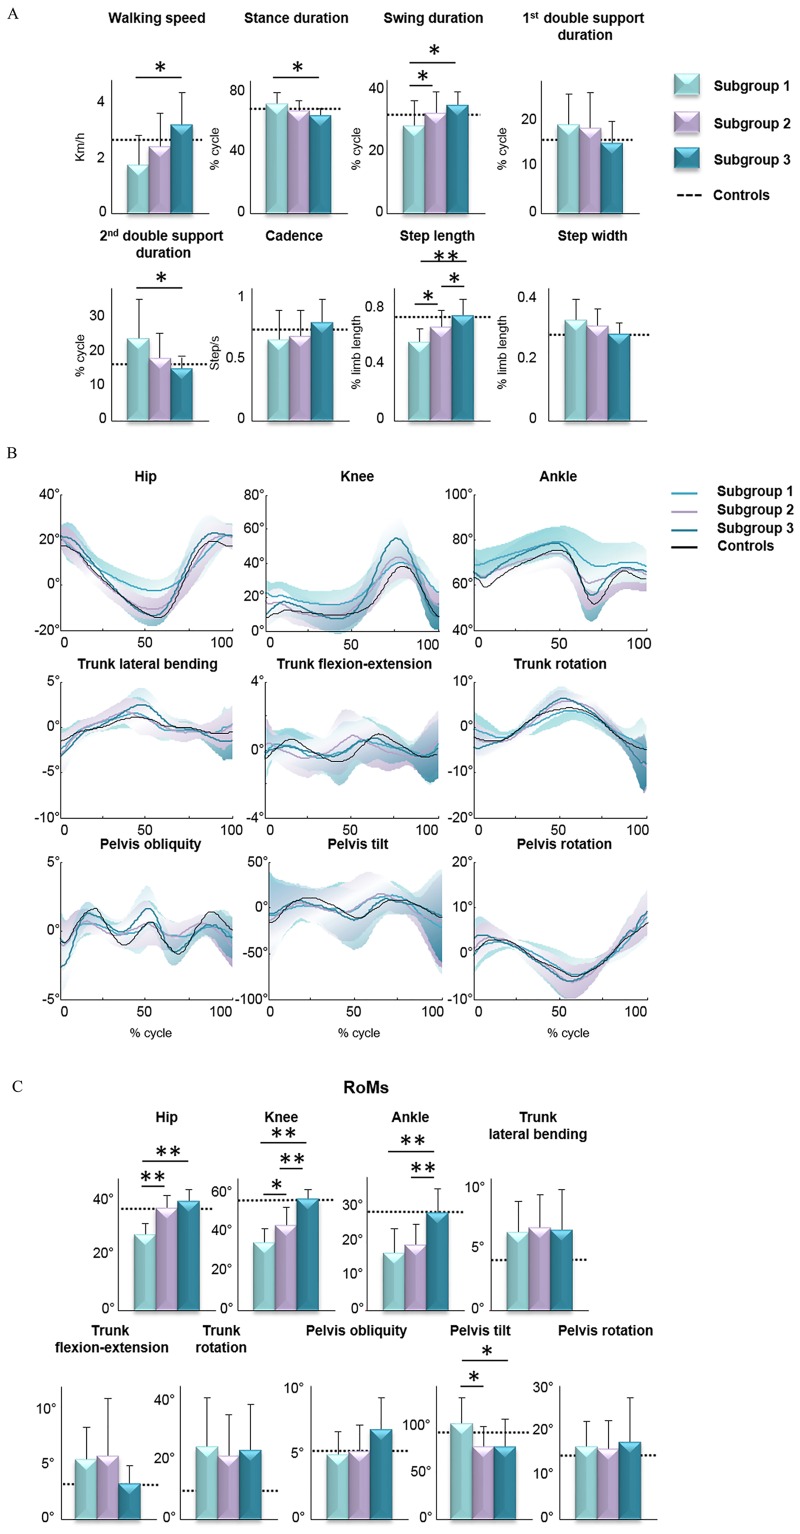
Time-distance and joint and trunk kinematic parameters in HSP subgroups.(A) Mean values (±SD) of time distance parameters. (B) (B) Mean (with SDs in light colors) kinematic plot of joint angular displacements during the gait cycle. (C) Mean values (±SD) of range of angular motion (RoM). Mean values of healthy controls for both time-distance and kinematic parameters, are reported in each bar graph (dotted line) and plot (black line). Asterisks indicate significant differences among the three subgroups at post hoc analysis (* p<0.05, ** p<0.001).